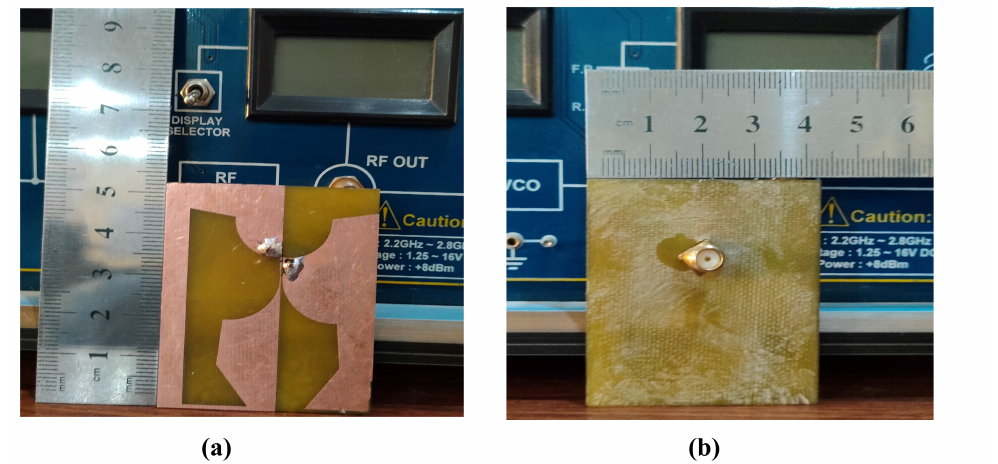
Figure 12. Prototype of the Proposed Antenna ( a ) top view ( b ) bottom view.